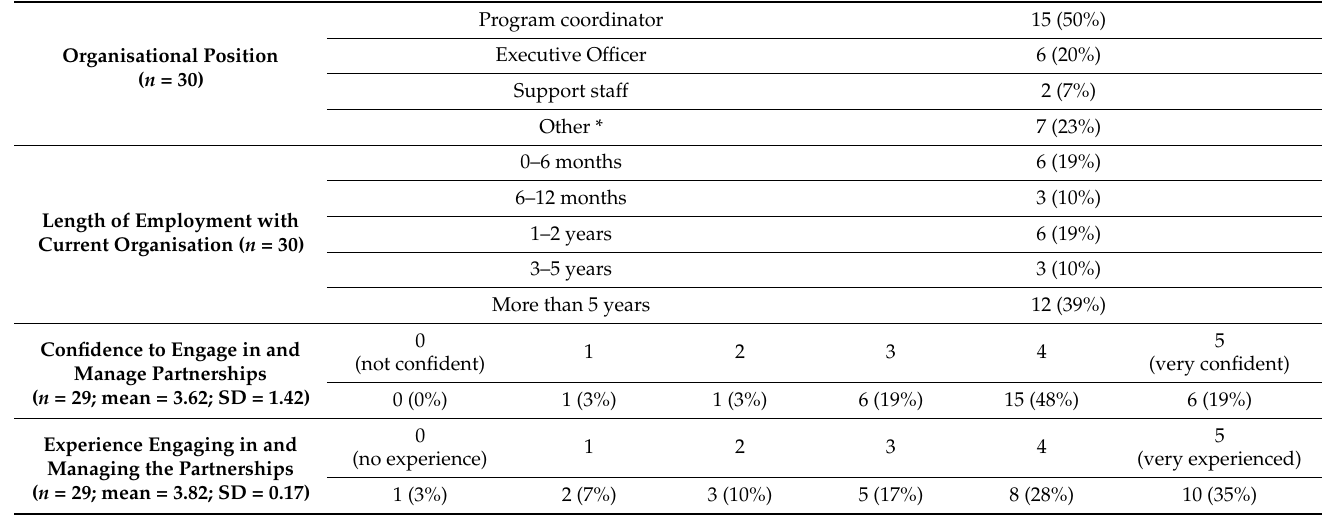
Table 1. Characteristics of participants ( n =